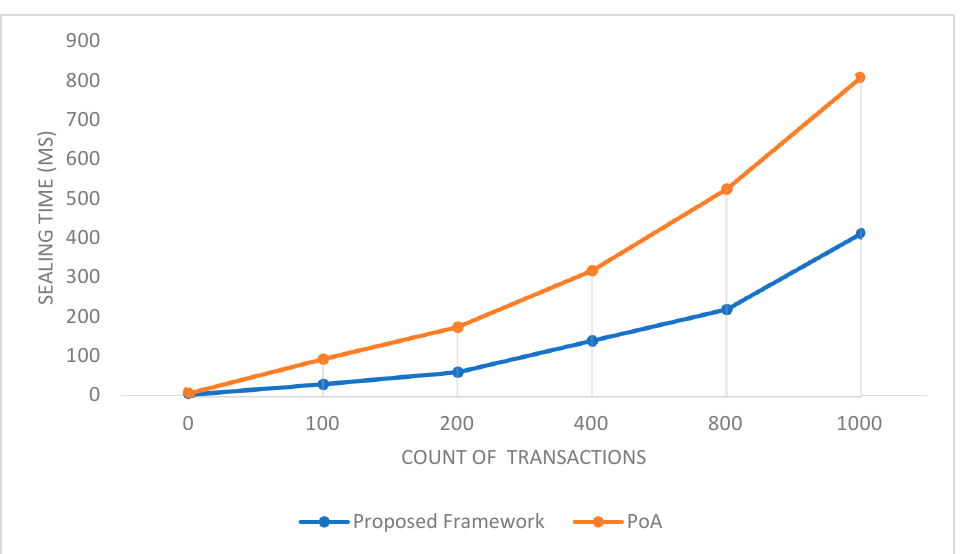
Figure 16. Average sealing time of proposed framework compared with PoA.